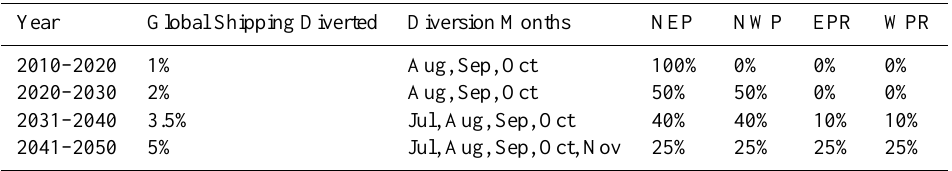
Table 12. Example of future through-Arctic shipping traffic diversions.